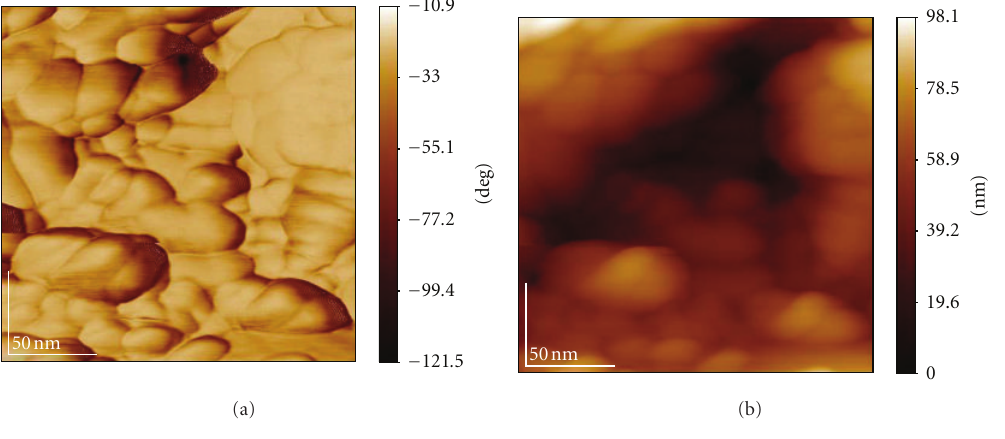
Figure 8: Phase and topography of as-coated